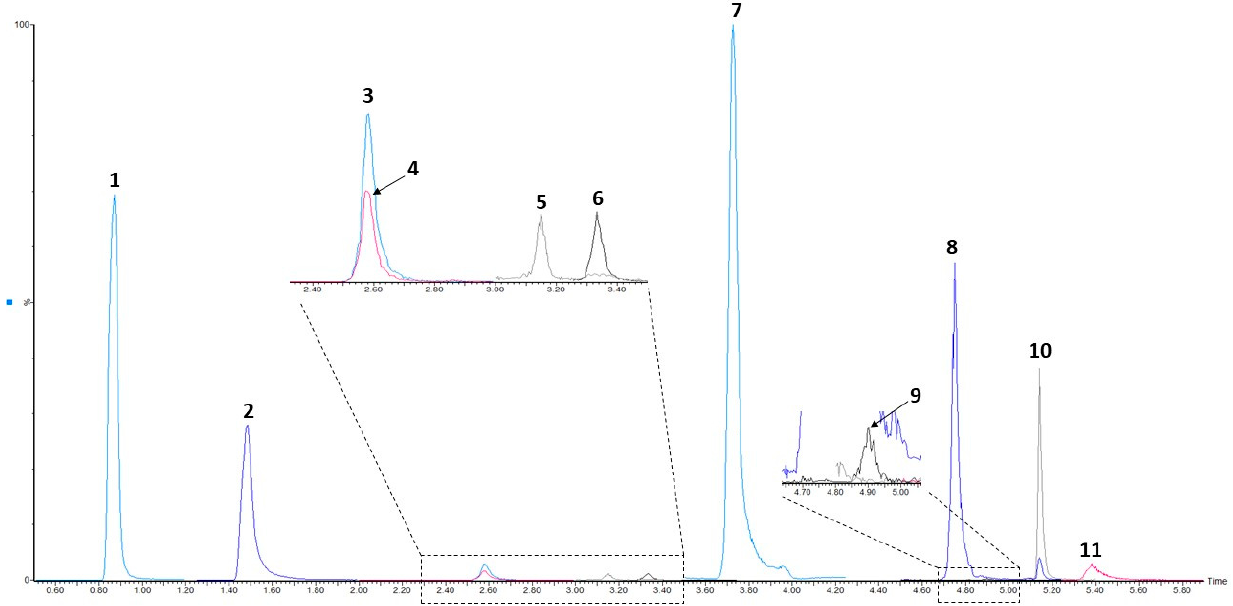
Figure 2. Overlapped representative SRM chromatograms obtained from the analysis of SHR 24 brain tissue sample from medulla oblongata. 1—Ach, 2—Chol, 3—Trp, 4—Kyn, 5—PyroGlu,